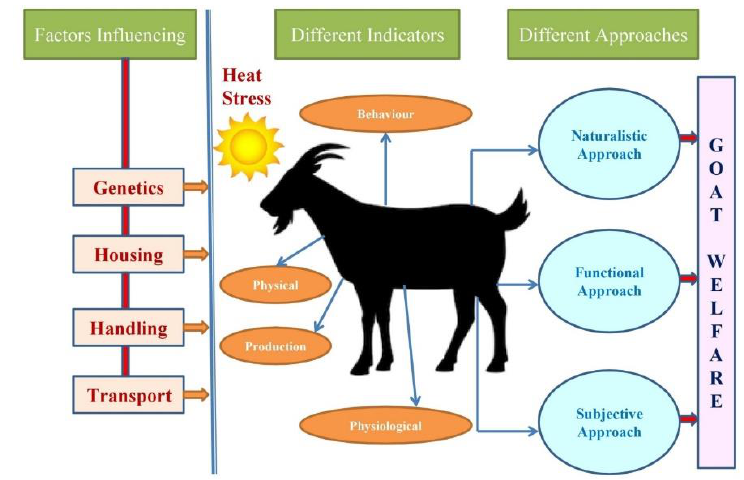
Figure 1. Concept of welfare assessment in